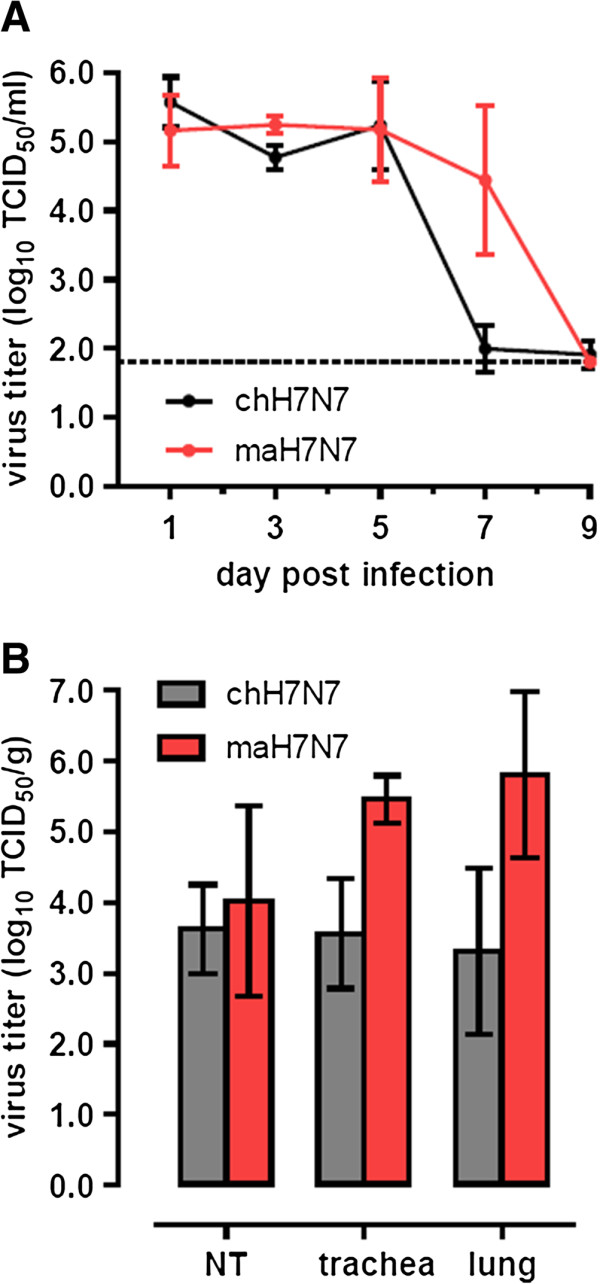
Replication of H7N7/03 viruses in the upper and lower respiratory tract of ferrets. A) Ferrets were i.n. inoculated with 107.4 TCID50 of virus and nasal washes collected at 1, 3, 5, 7 and 9 days p.i. were titrated in MDCK cells. Mean virus titers (n=4) are shown with error bars indicating standard deviations. The dotted line indicates the lower limit of detection. B) Mean virus titers in nasal turbinate (NT), trachea and lung tissues collected from ferrets (n=3) on day 5 p.i. Error bars represent the standard deviations.